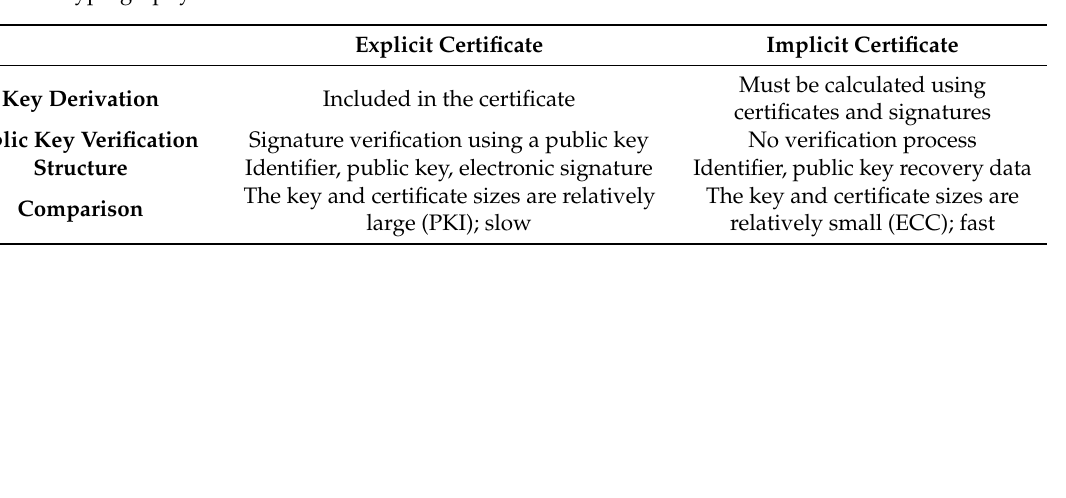
Figure 3. Mutual authentication flow with certificate.